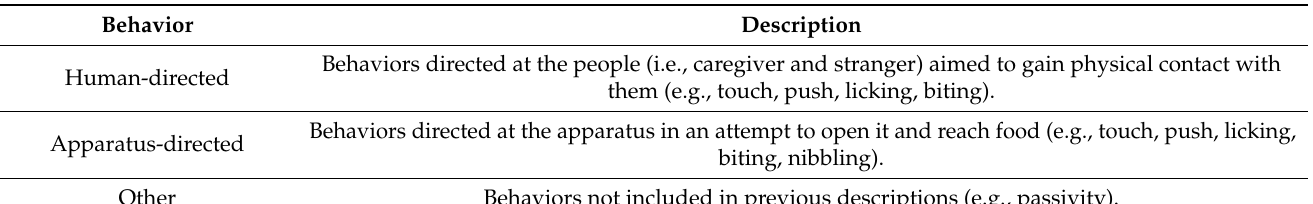
Table 1. Ethogram in the impossible